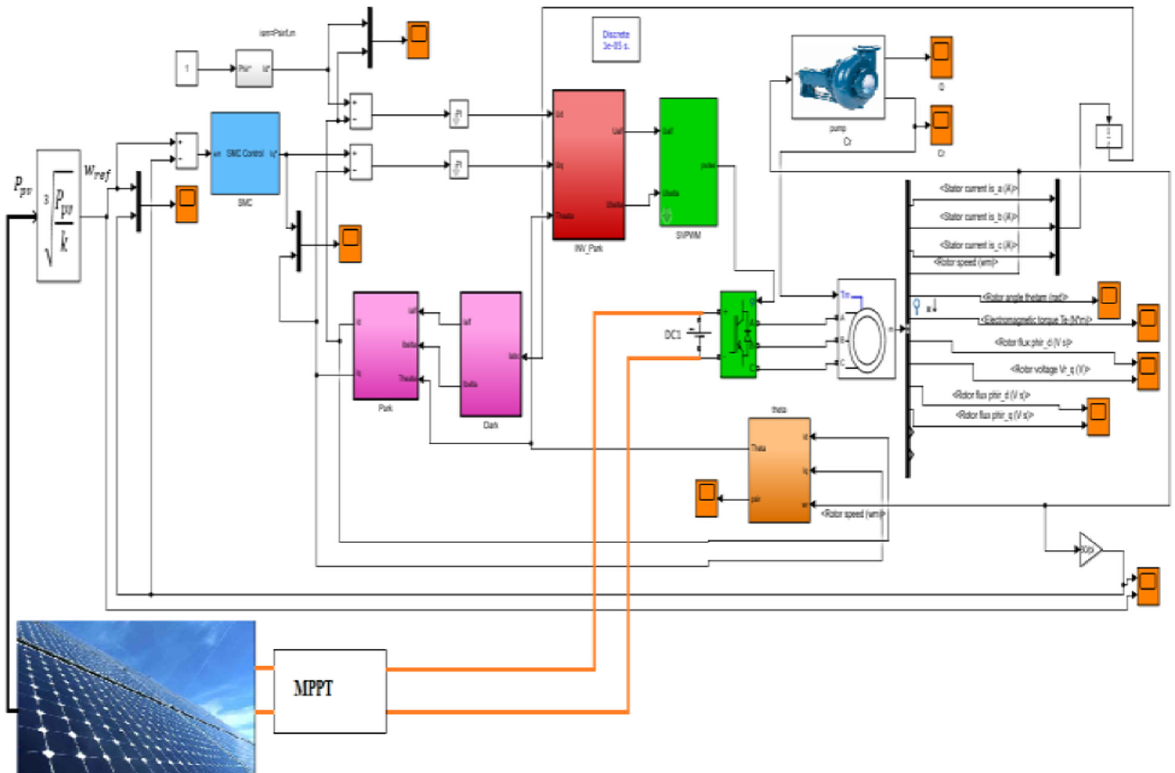
Fig. 14 MATLAB/Simulink model of the pumping system